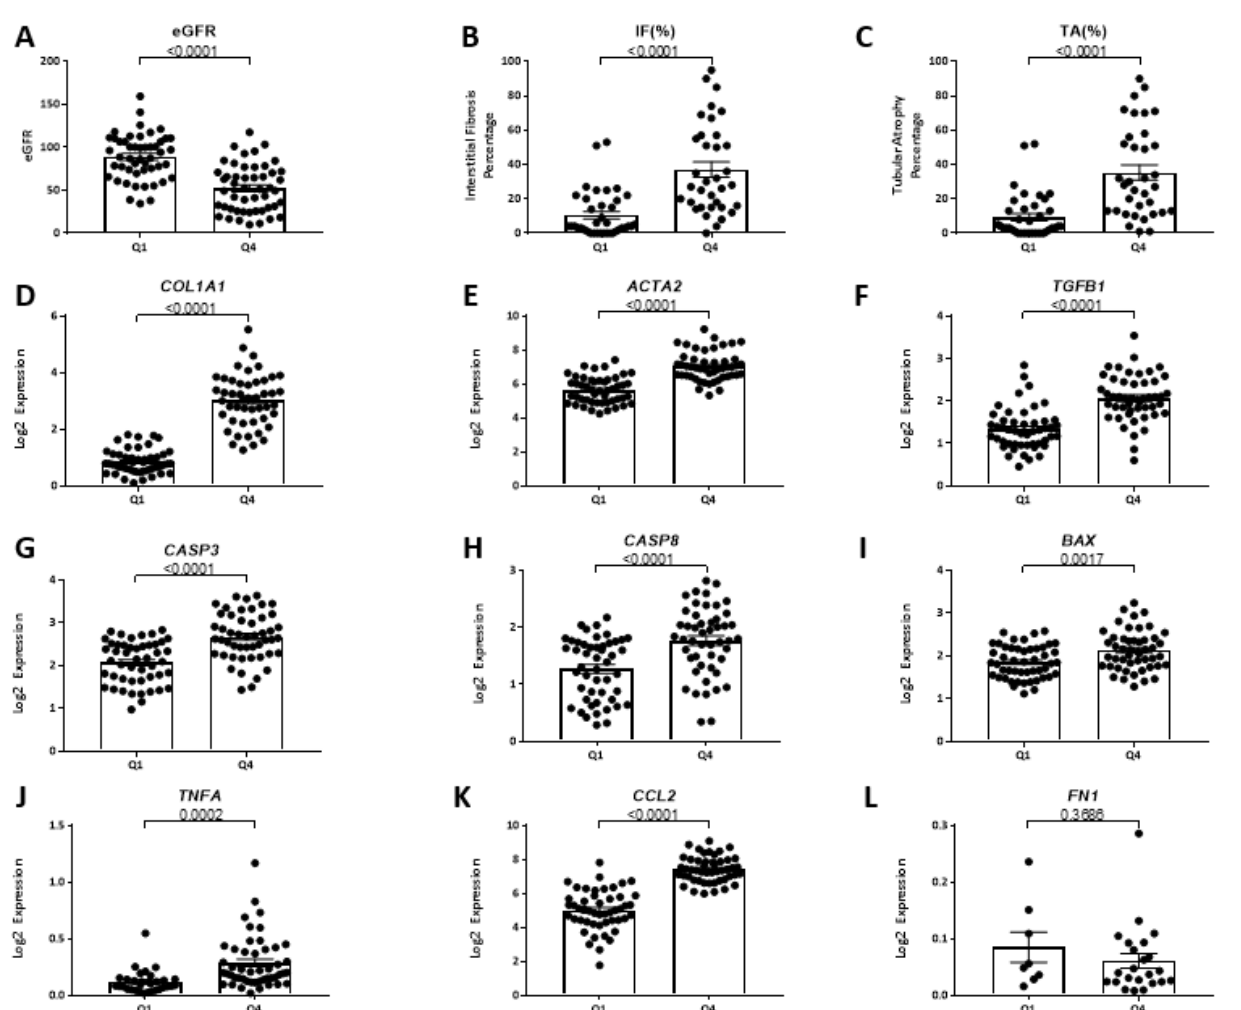
Figure 21. Forest Plot of End Point Analysis. The odds ratio (OR) with 95 percent confidence intervals for reaching the end point in the second, third, and fourth quartiles of baseline FSTL1 mRNA levels. The first quartile was the reference group. The OR was not adjusted for baseline clinical variables.